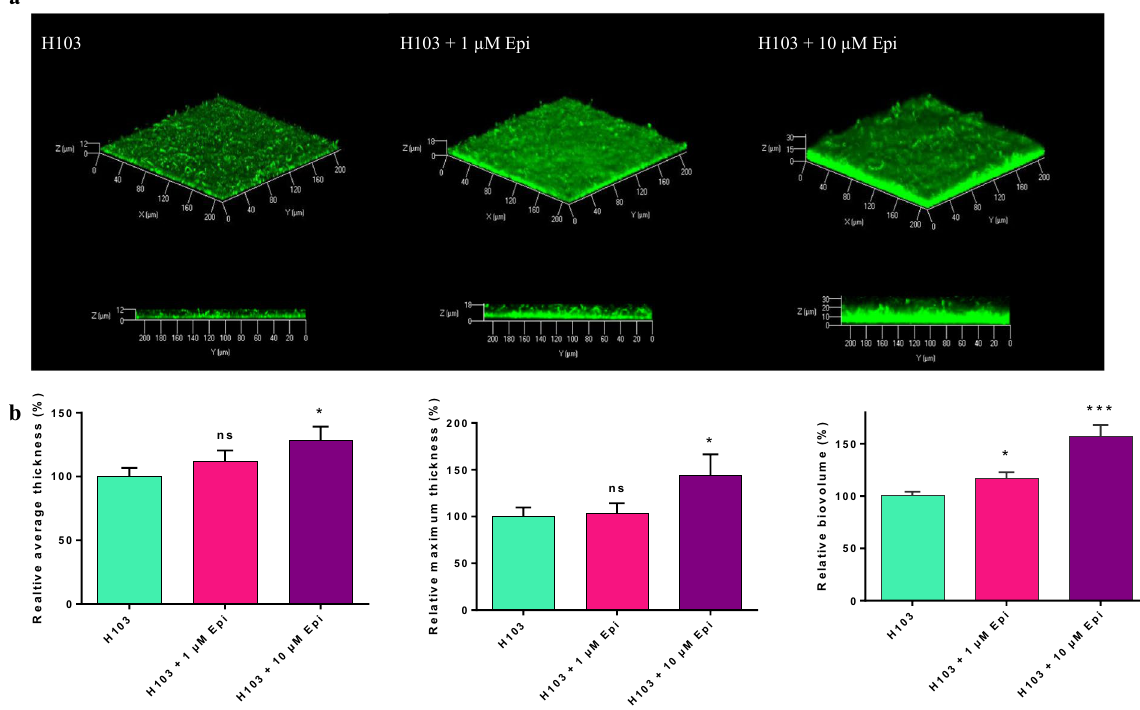
Figure 4. Effect of Epi on P. aeruginosa H103 biofilm formation. ( a ) Three dimensional (3D) and side views of P. aeruginosa H103-GFP 24 h biofilm observed by CLSM, in presence of 1 or 10 µ M of Epi. ( b ) Images analysis by COMSTAT. Data were normalized according to the untreated control set at 100%. The error bars indicate the standard error of the mean (SEM) of at least three independent experiments. Two-tailed paired t -test was used (n = 4), * p < 0.05, *** p < 0.001, ns: not